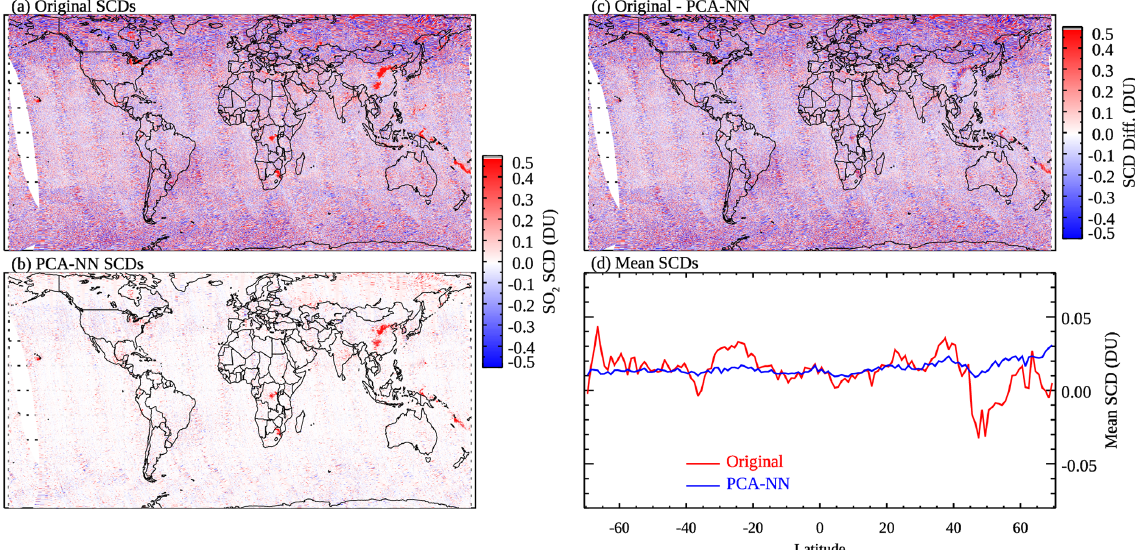
Figure 11. OMI SO 2 SCDs for 16 April 2005 retrieved using (a) the original PCA algorithm and (b) a PCA–NN algorithm, (c) the differences between the two retrievals, and (d) mean SO 2 SCDs for 1 ◦ latitude bands over relatively clean areas (monthly mean SRR < 3), calculated from (red) the original and (blue) PCA–NN